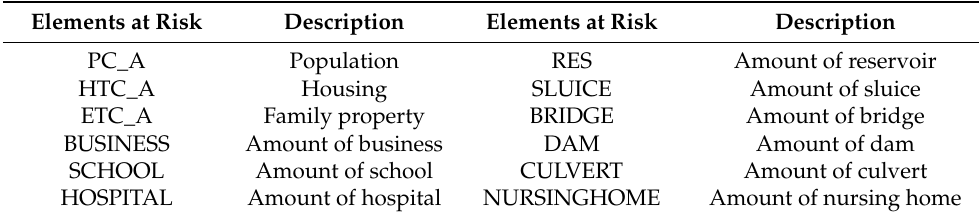
Table 3. Statistics on Households, Enterprises and Projects in Small Watersheds.